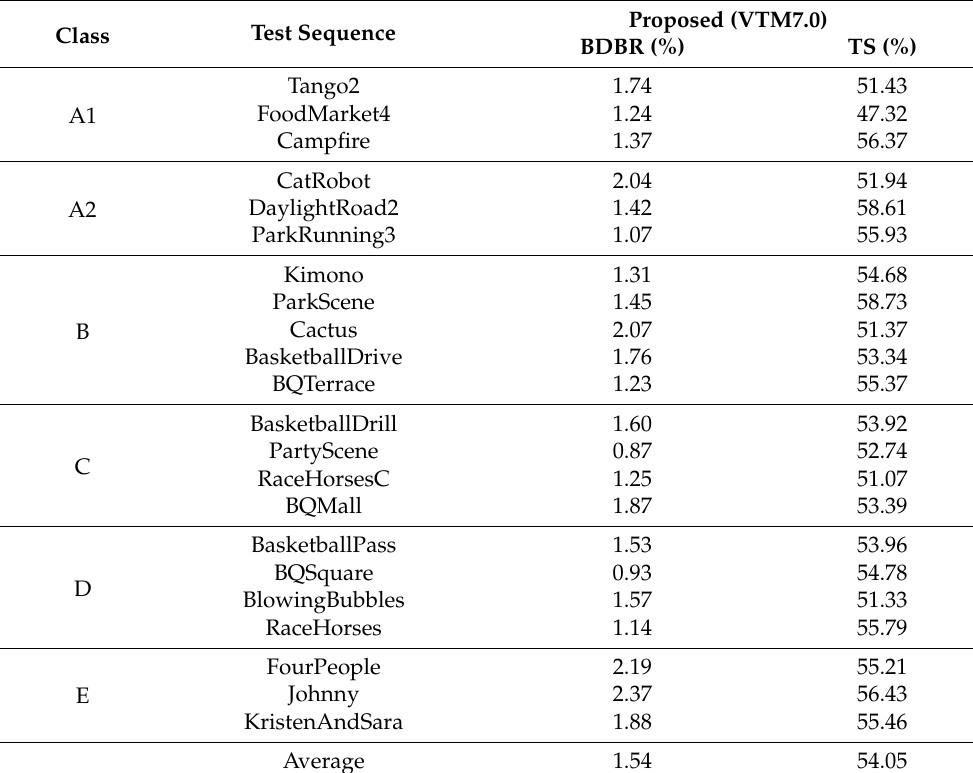
Table 1. Encoding performance of proposed algorithm compares with VTM7.0. Class Test